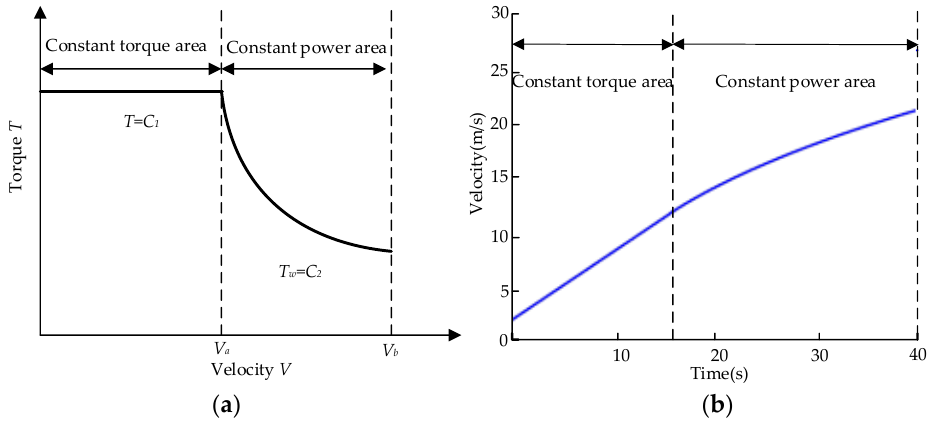
Figure 4. ( a ) Traction characteristic curve; and ( b ) speed curve under traction condition.